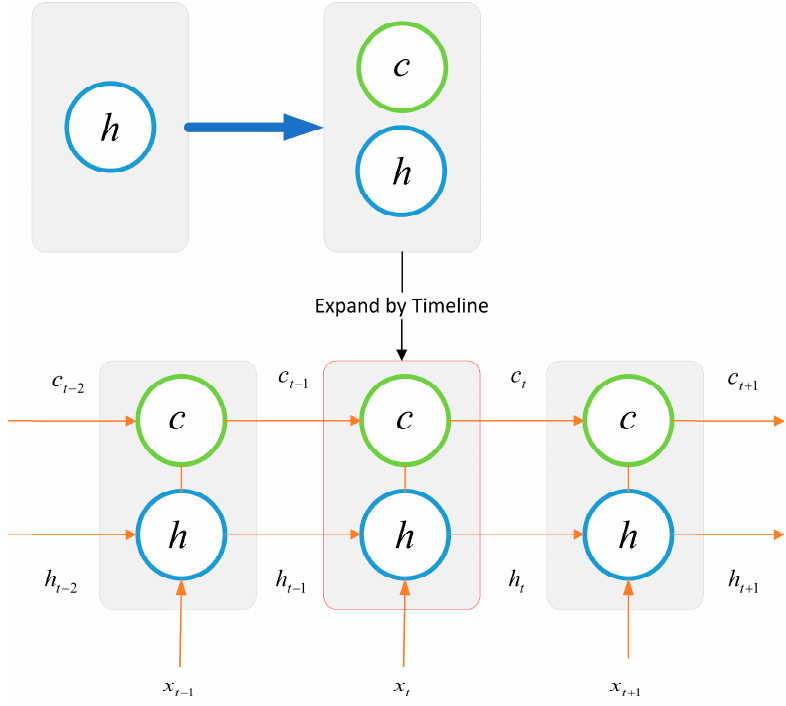
Figure 4. Cell state.